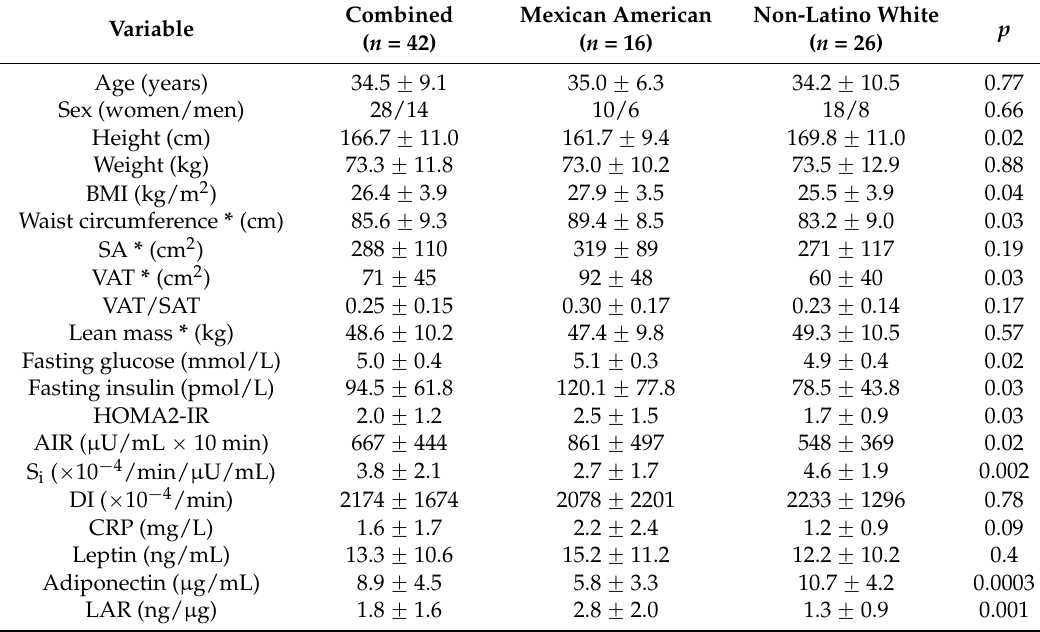
Table 1. Demographic characteristics and clinical measures by ethnicity.